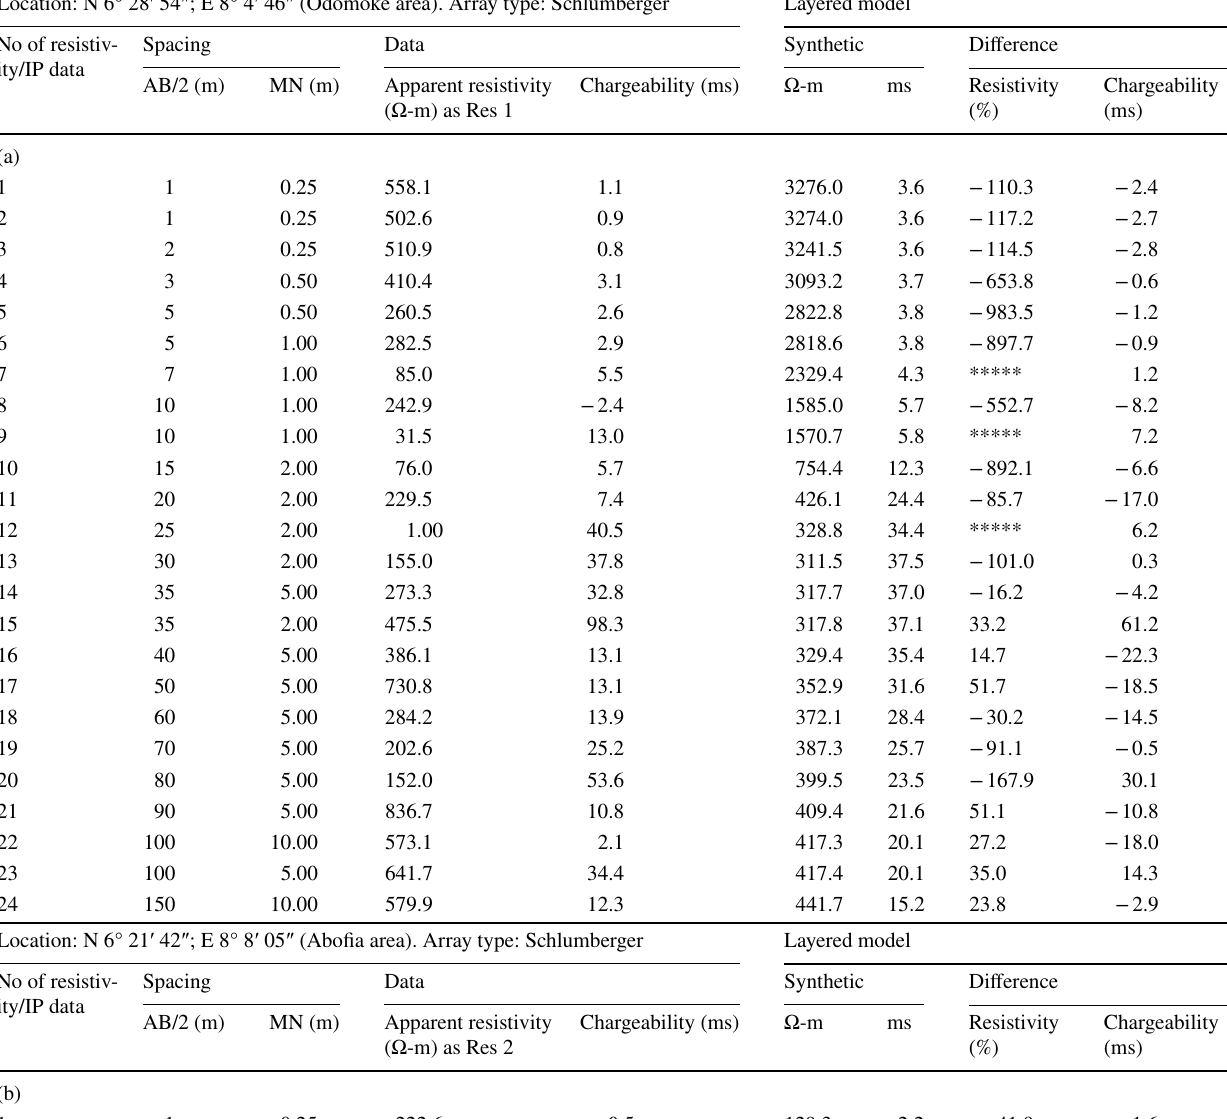
Table 5 (a) Geophysical data from Odomoke area for Fig. 6b, (b) geophysical data from Abofia area for Fig. 7b, (c) geophysical data from Agalegu area for Fig.